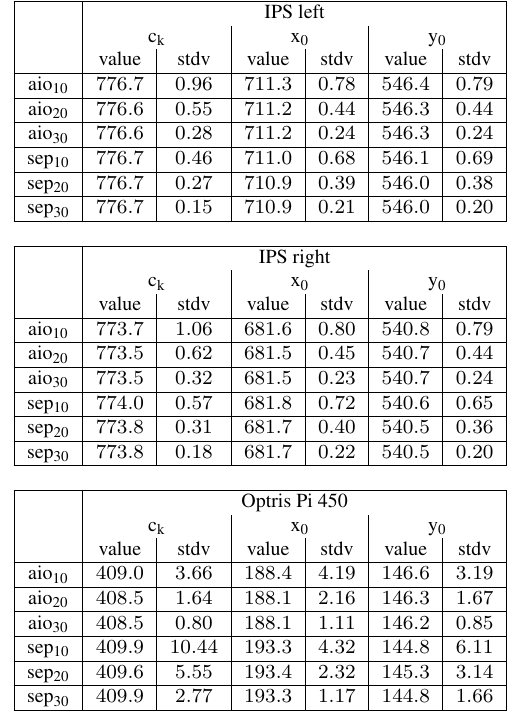
Table 2. Comparison for an all-in-one (aio) or seperate (sep) bundle adjustment with 10 , 20 and 30 random samples. On top and in the middle are intrinsic parameters of the visual IPS stereo cameras and at the bottom the values for the thermal imaging sensor in [ px ].